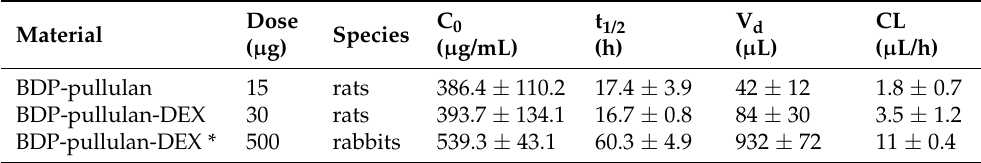
Table 2. Kinetic parameters of intravitreally injected fluorescently labelled: BDP-pullulan ( n = 6 rat eyes) and BDP-pullulan-DEX ( n = 5 rat eyes; n = 6 rabbit eyes) derived from fluorophotometric